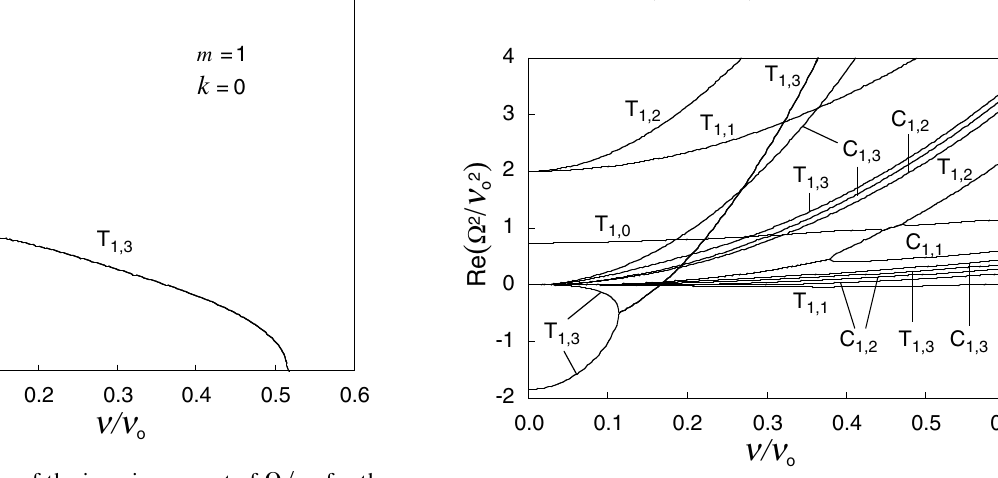
for the first 16 dipole modes as o for ak (cid:3) 2 : 0 , b=a (cid:3) 1 : 5 , and zero wall o